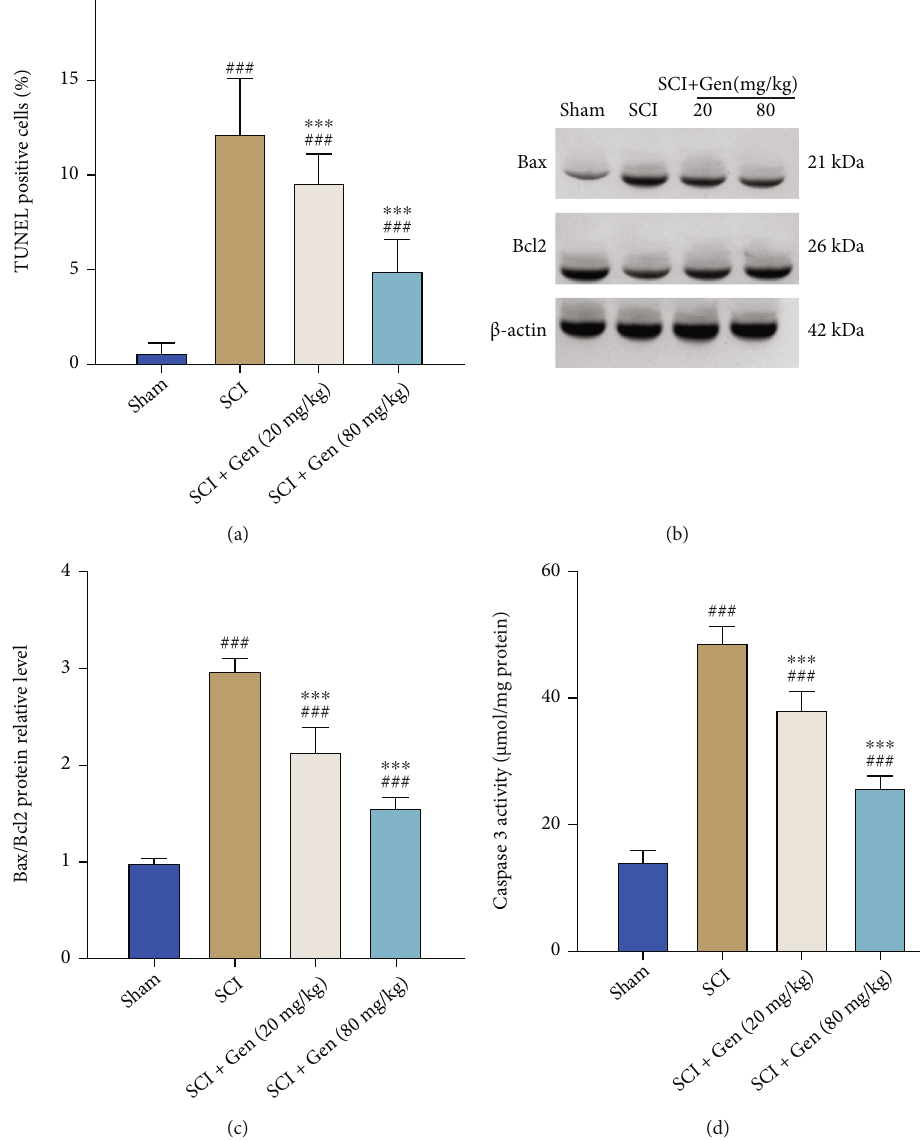
Figure 2: Genistein reduced apoptosis in SCI mice. (a) 28 days after Genistein treatment, TUNEL staining was used to determine the apoptosis in the SCI area. (b and c) 28 days after genistein treatment, immunoblotting was used to detect the expression of Bax and Bcl2 protein in the SCI area, and the representative protein bands were showed in (b), and the gray value comparison of protein bands was shown in (c). (d) 28 days after genistein treatment, the activity of caspase 3 in the SCI area was determined using ELISA kit. Five mice in each group, and data were expressed as mean ± SD . P value was calculated by post hoc comparisons. ∗ P < 0 : 05 , ∗∗ P < 0 : 01 , and ∗∗∗ P < 0 : 001 vs. SCI group. ## P < 0 : 01 and ### P < 0 : 001 vs. sham